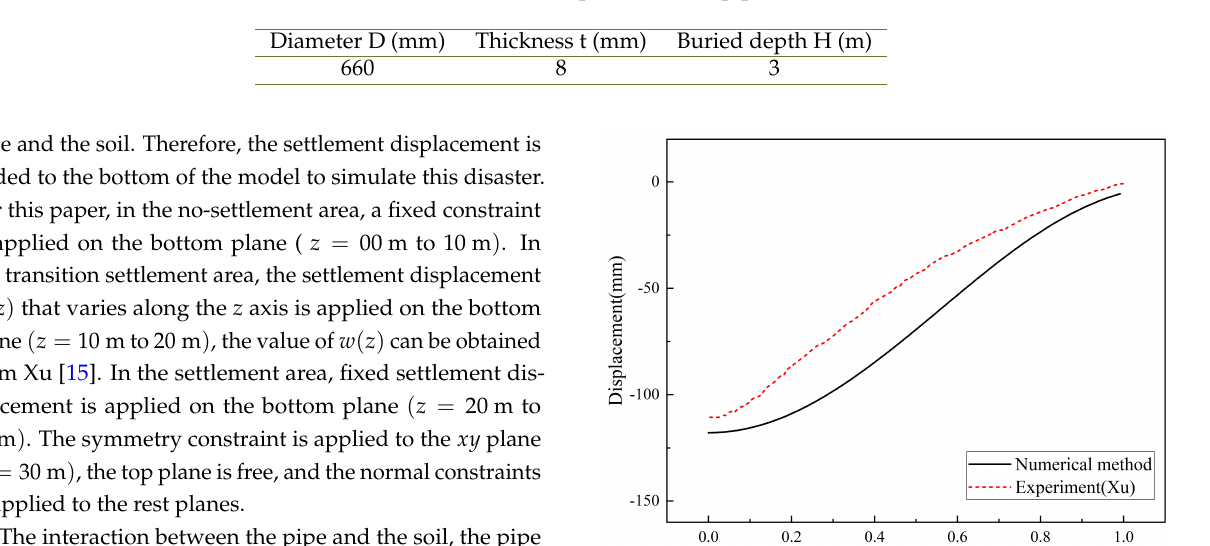
Table 2. Geometries parameters of pipe